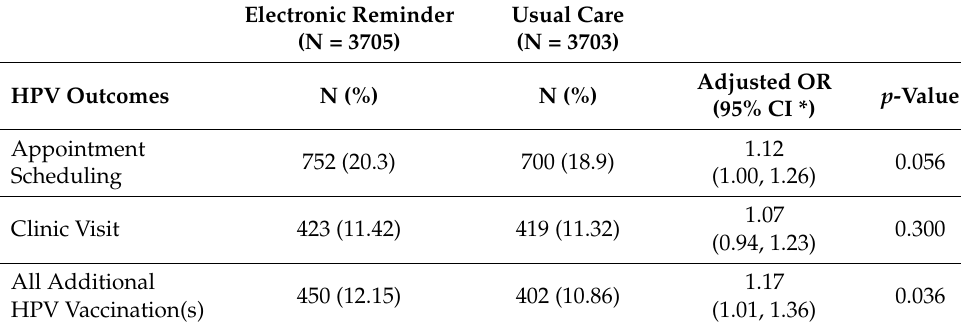
Table 3. Multiple logistic regression * analysis results of HPV